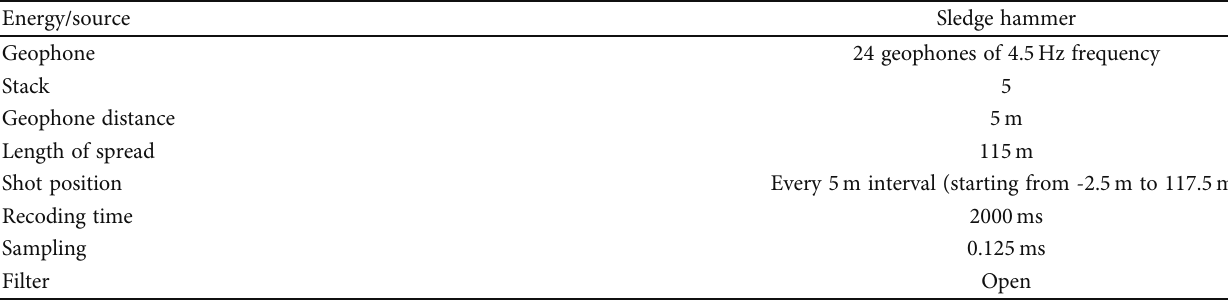
Table 2: MASW data acquisition